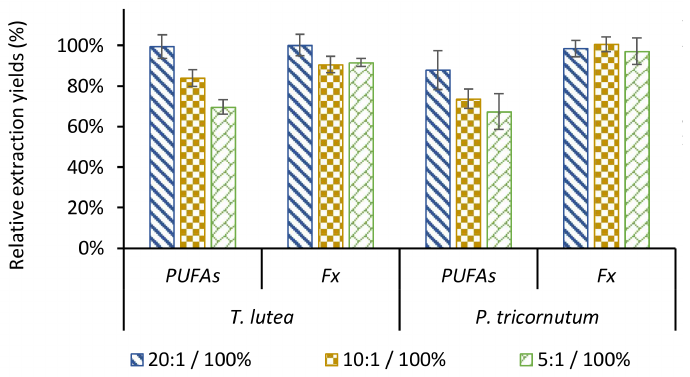
Figure 4. Comparison of the extraction yields of fucoxanthin (Fx) and total long chain polyunsaturated fatty acids (PUFAs) obtained with different ethanol/biomass ratios for 90 min at 30 ◦ C ( T. lutea ) or for 24 h at 40 ◦ C ( P. tricornutum ) with 96% ethanol in closed system with magnetic stirring. 100% references were determined from extractions with 96% ethanol ( T. lutea ) or 100% methanol ( P. tricornutum ) for Fx, and from direct transesterification of lipids from dry biomass into fatty acids methyl esters for PUFAs. Significant differences between data are represented by different letters. The relative ratios were compared for a given molecular family and species. ( p -value ≤ 0.05, n = 3